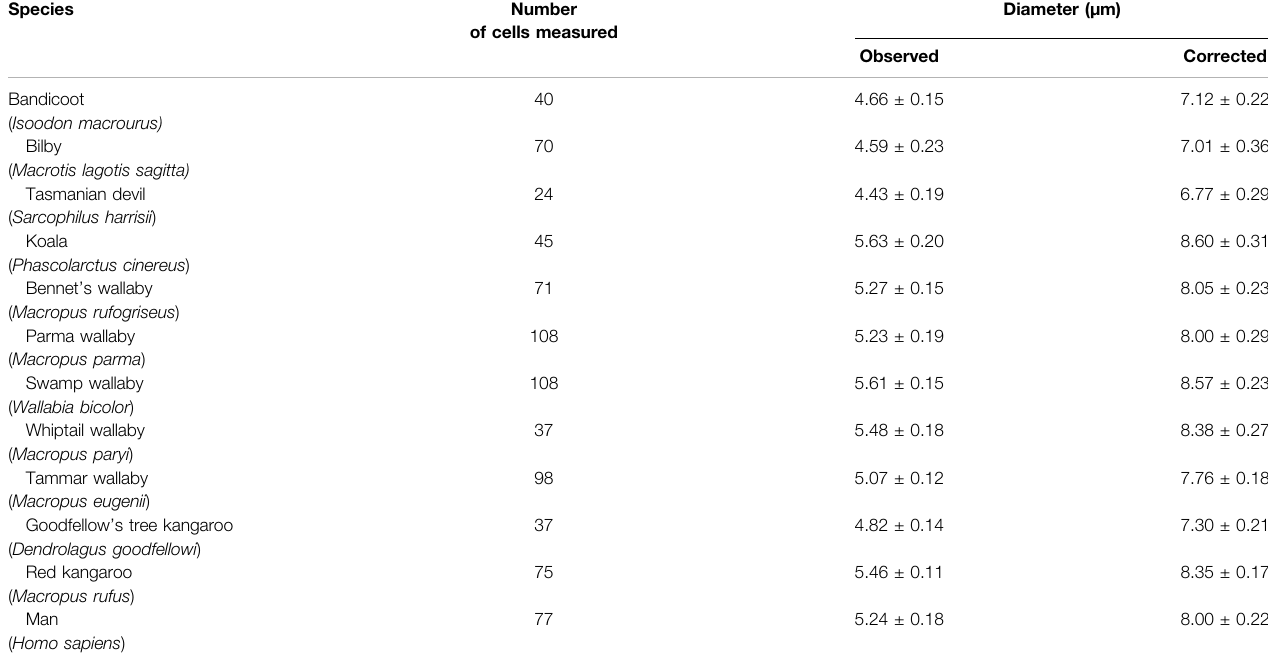
TABLE 1 | Diameters of animal RBC compared with human RBC, measured by electron microscopy. Species